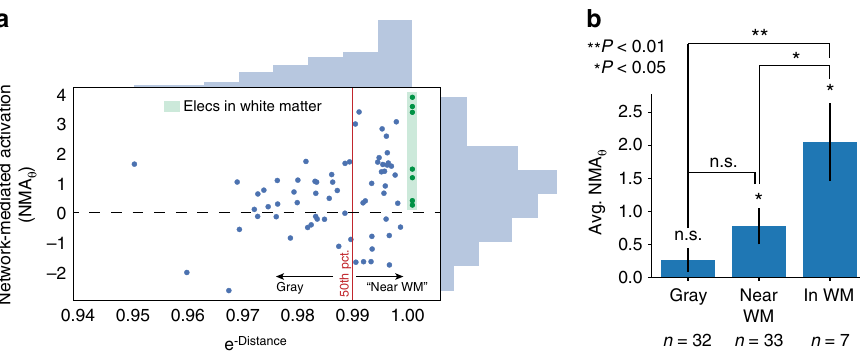
Fig. 3 Proximity to white matter predicts NMA θ . a Correlation between a stimulation site ’ s distance from nearest white matter with the site ’ s NMA θ . The 50th percentile of white matter distances divides sites classi fi ed as “ gray matter ” vs. “ near white matter. ” Stimulated contacts in white matter are highlighted in green. See Supplementary Figure 3 for the Pearson correlation of these data ( r = 0.33, P = 0.005). b NMA θ increases with closeness to white matter, as determined by a permutation test ( P < 0.001, see Methods) and by noting that NMA θ for sites in or near white matter are signi fi cantly greater than zero (one-sample t -test, P < 0.05) while gray matter sites are not ( P = 0.15). Electrodes placed in white matter have greater NMA θ than electrodes near white matter (two-sample t -test, P < 0.05) or gray matter ( P < 0.01). Error bars show ±1 SEM; * P < 0.05; ** P